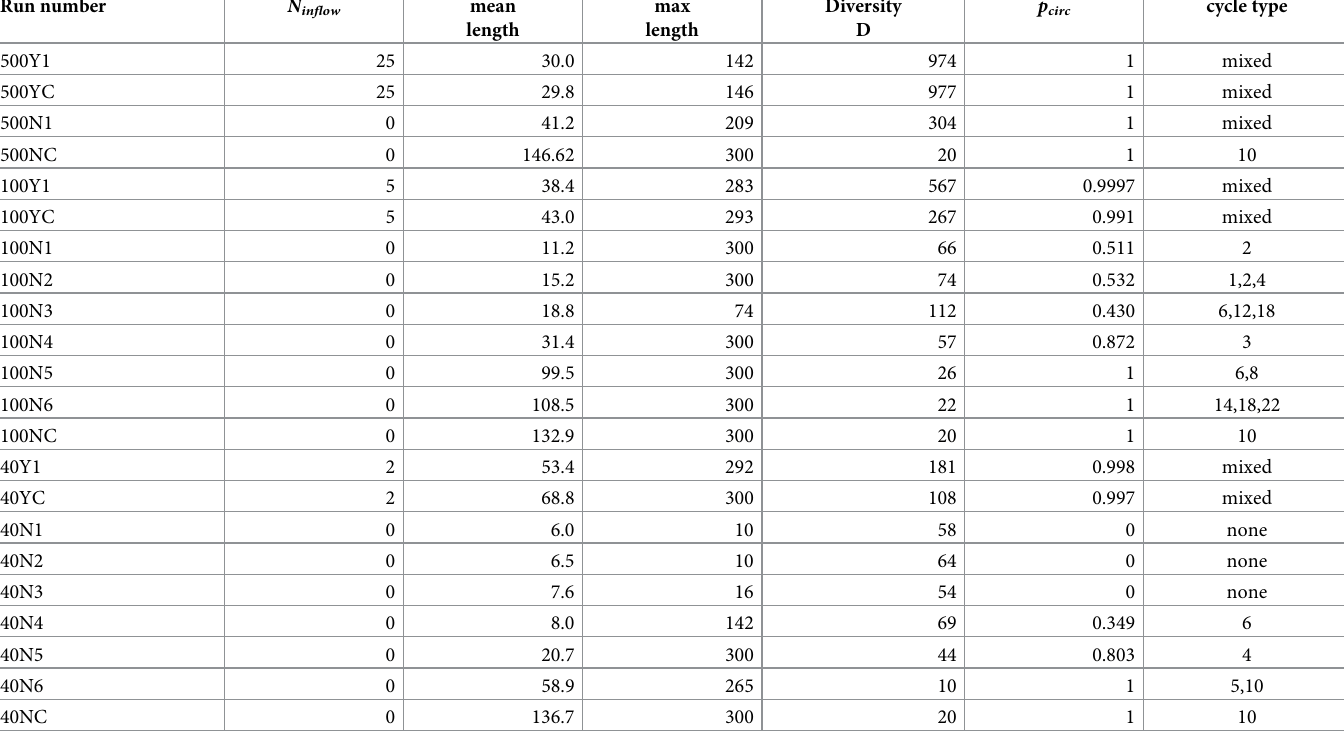
Table 5. Summary of runs used to investigate the possibility of virtual circular